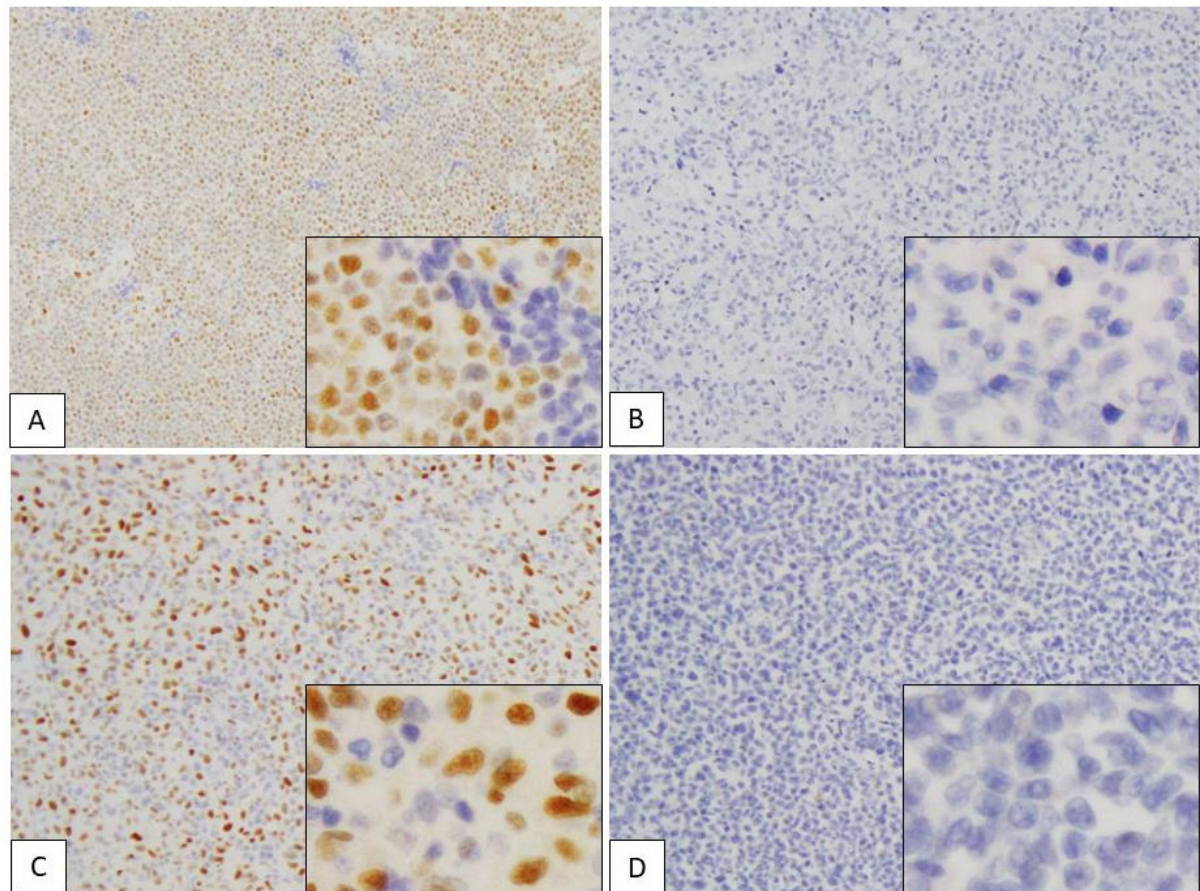
Figure 4. Immunohistochemical assessment of SOX4 in adult T-cell leukemia/lymphoma (ATLL) and peripheral T-cell lymphoma, not otherwise specified (PTCL-NOS). ( A – D ) SOX4 expression in the nuclei of lymphoma cells. ( A ) ATLL case showing high expression (positive cells score 3 + stain intensity score 3 = total score 6). ( B ) ATLL case showing no expression (positive cells score 0 + stain intensity score 0 = total score 0). ( C ) PTCL-NOS case showing high expression (positive cells score 3 + stain intensity score 3 = total score 6). ( D ) PTCL-NOS case showing no expression (positive cells score 0 + intensity score 0 = total score 0). Each subpanel shows positive cells from a high-power field of view (×400).